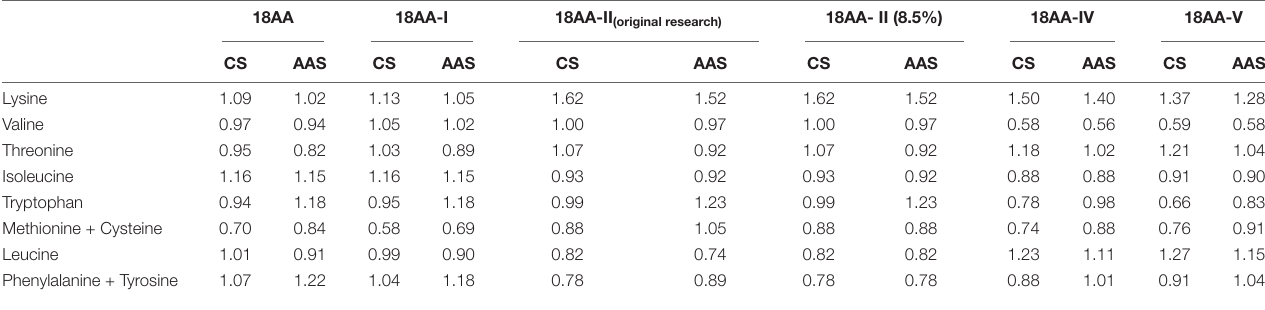
TABLE 4 | The CS and ASS of 18AA-II original research and five formulations of amino acids for injection.